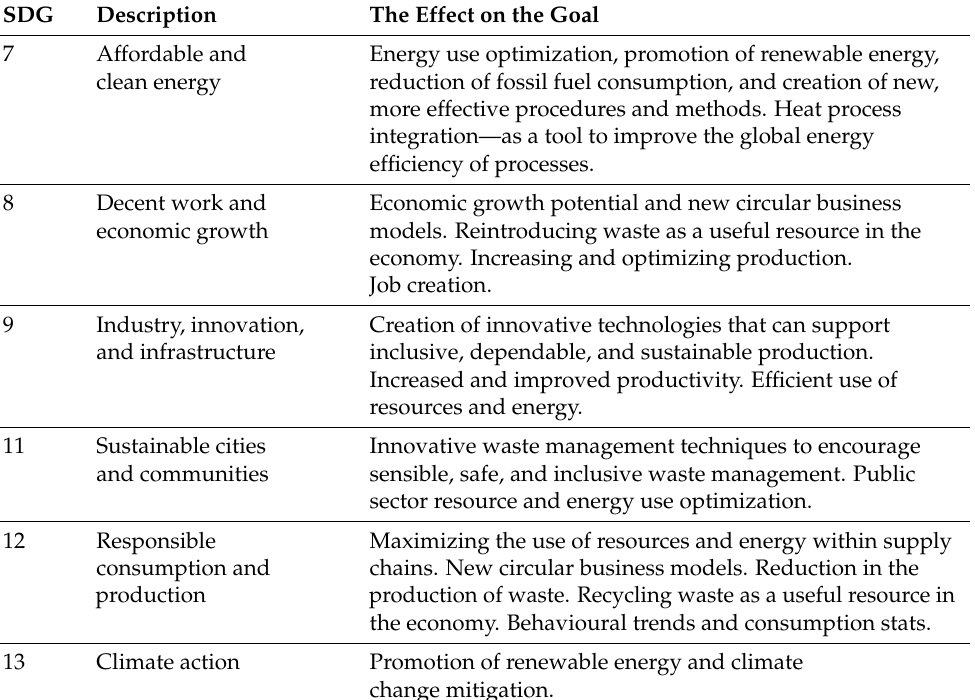
Table 2. SDG targets affected by a circular economy, and the application of newer 4IR